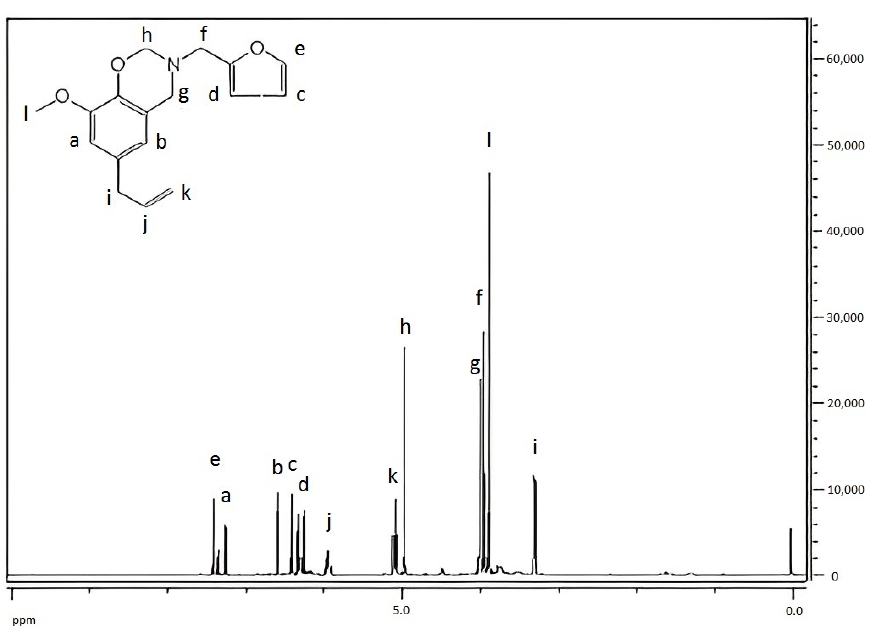
Figure 7. Mass spectrogram of benzoxazine (eugenol).